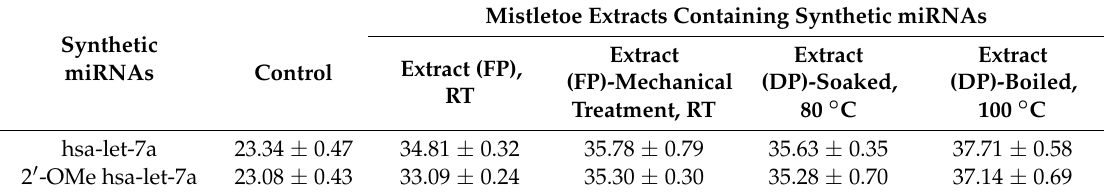
Table 3. The Ct values of synthetic miRNAs processed together with mistletoe preparations.